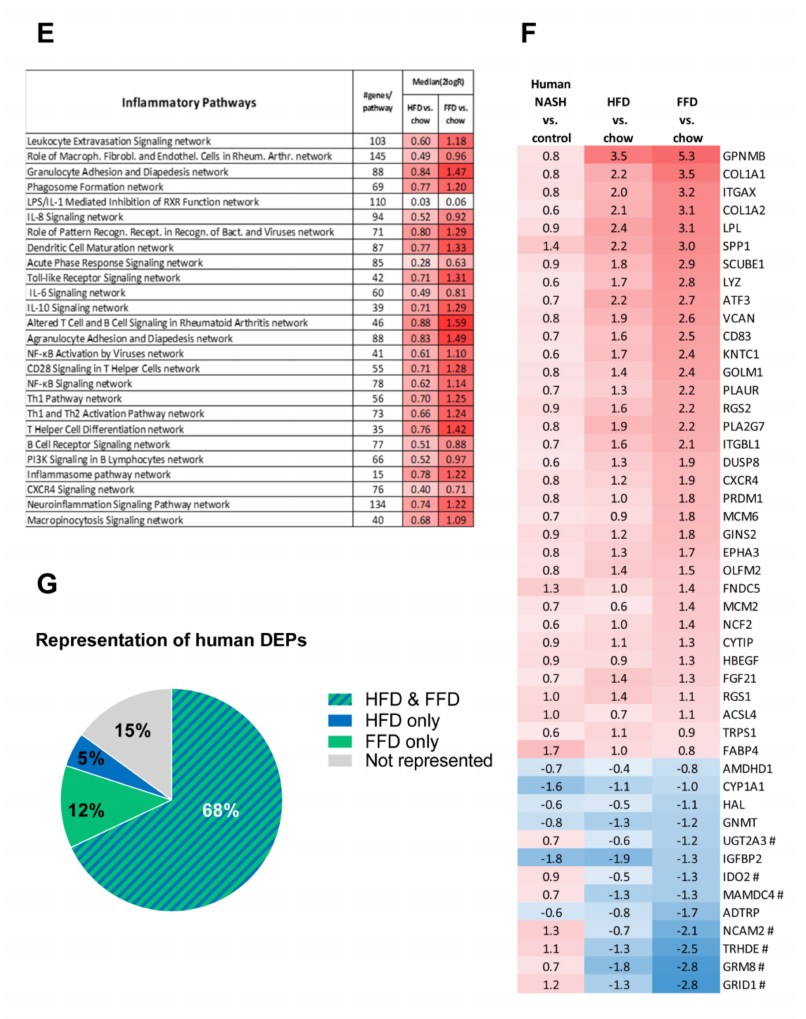
Figure 4. Venn diagram ( A ) illustrating the overlap of di ff erentially expressed pathways (pathway p val < 0.01) of livers between Ldlr − / − .Leiden mice fed a high-fat diet (HFD) vs. healthy chow diet (blue circle) or fed a fast food diet (FFD) vs. healthy chow diet (green circle) for 28 weeks. N ≥ 8 mice per group. The shared top 10 of significantly enriched biological processes ( − log ( p -value)) for the genes a ff ected by HFD (blue bars) and FFD (green bars) vs. chow ( B ). Di ff erences between HFD and FFD in downregulation of ATP synthases in complex V of oxidative phosphorylation ( C ). Quantification of 4-hydroxynonenal (4-HNE) marker of oxidative stress using stained liver sections ** p < 0.01 and *** p < 0.001 vs. chow or * p < 0.05 FFD + OCA vs. FFD t = 28 (as indicated by bar) ( D ). E ff ect of HFD and FFD on di ff erent inflammatory pathways, expressed as median (2logR) of all genes in the listed inflammatory pathway ( E ). Heatmap showing expression of genes di ff erentially regulated in human non-alcoholic steatohepatitis (NASH) vs. normal controls [6] in Ldlr − / − .Leiden mice fed the HFD or FFD for 28 weeks relative to chow ( F ). Blue color indicates downregulation, and red color indicates upregulation. Genes with # indicate genes with di ff erential regulation vs. human regulation. Visualization ( G ) of the di ff erentially expressed pathways (DEPs) distinguishing human NASH patients vs. normal controls and representation thereof in the mice on HFD or